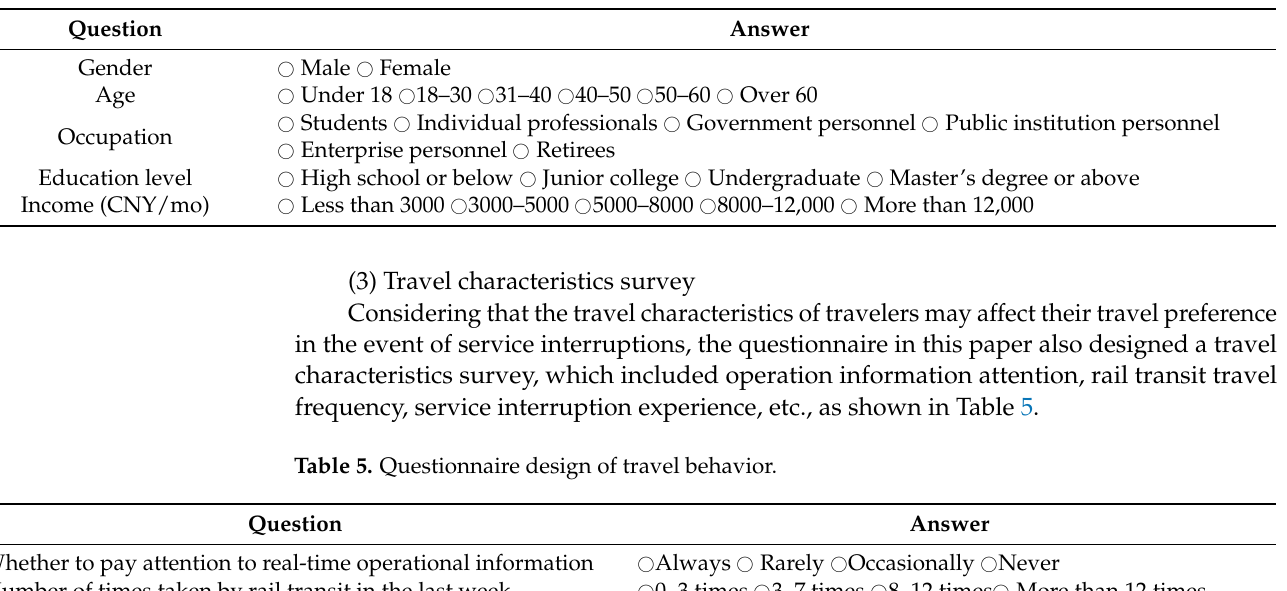
Table 4. Table 4. Questionnaire design of personal attributes.